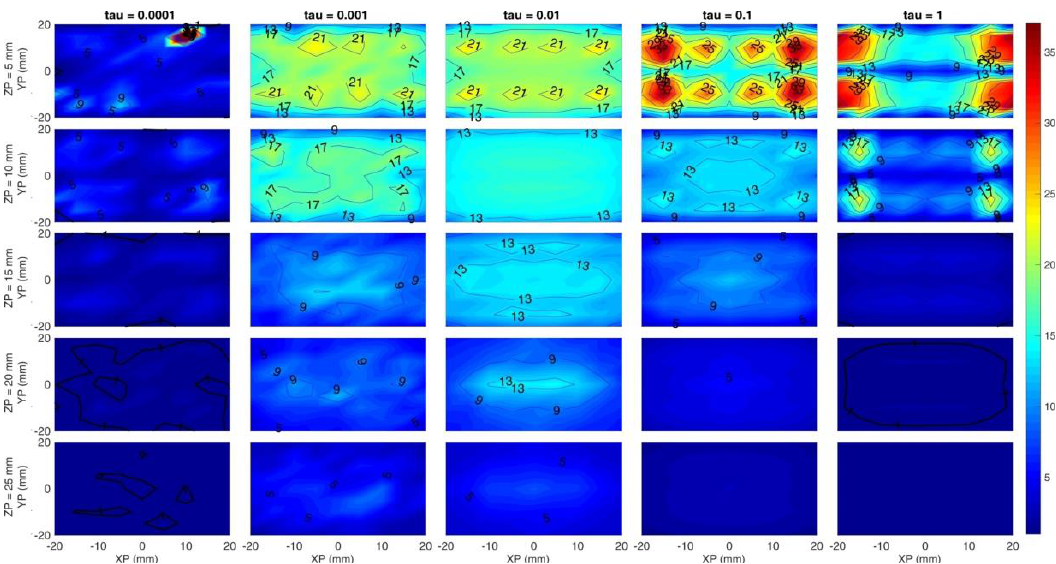
Figure 7. Map of the CNR on the absorption coefficient. Horizontal axis of each subplot is the simulated x position of the inclusion and vertical axis is the simulated y position. Rows are for different z coordinates of the inclusion while the columns for different 𝜏 . Colors show a range from 1 (blue) to 37 (red), that is the maximum CNR obtained.